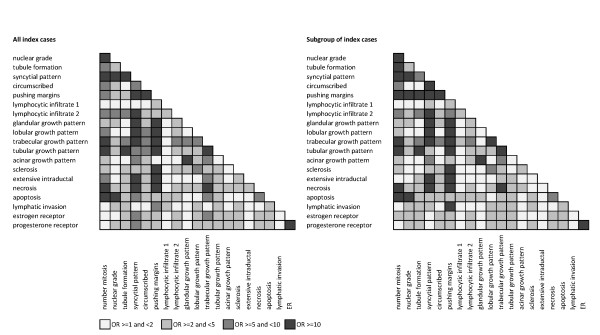
Associations between pathology features for all index cases (left) and the subgroup of cases (right). Each row and column corresponds to a feature and the shading represents different levels of association, as measured by the odds ratios (ORs), as indicated. Odds ratios <1 were assigned the same levels as their reciprocals.